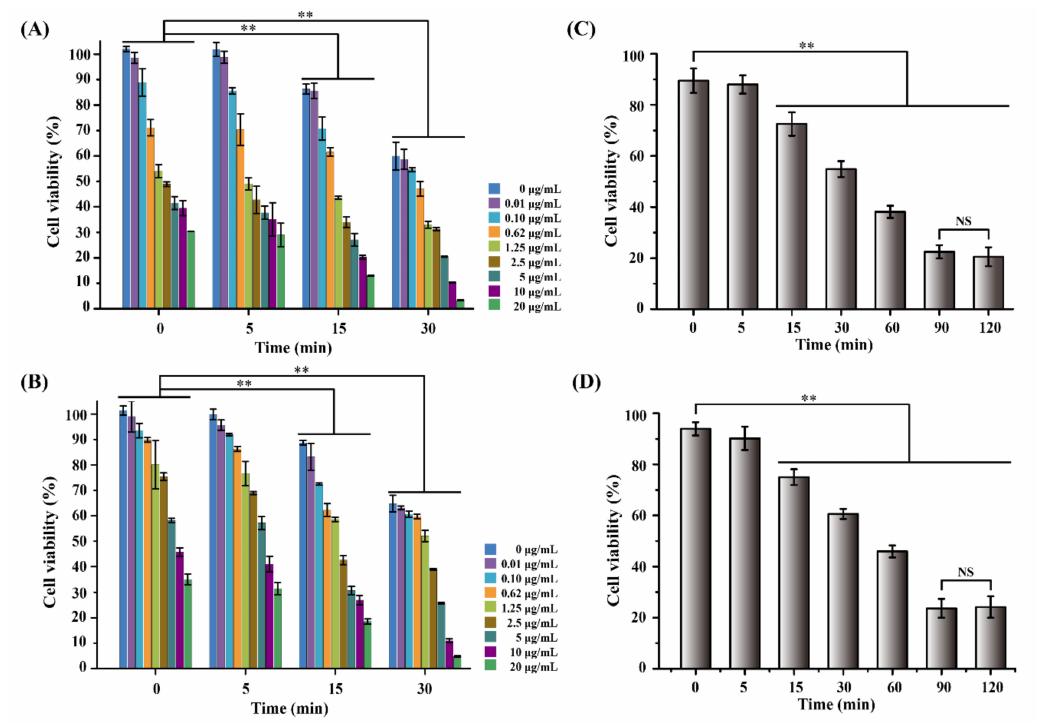
Figure 4. Viability of MCF-7 cells treated with different concentration of ( A ) DOX and ( B ) 17AAG, and different heating time ( C ) DOX (0.1 µ g/mL) and ( D ) 17AAG (0.1 µ g/mL). (NS means No significance; Data are mean ± SD, n = 6, ** p <